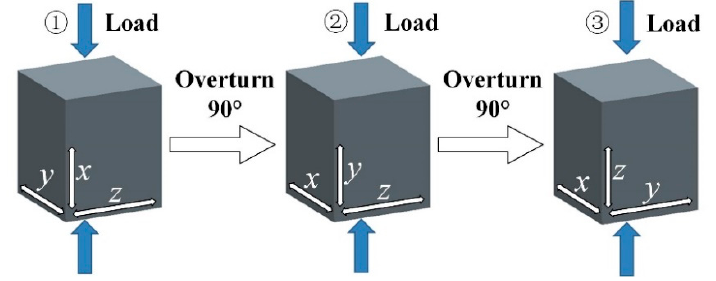
Figure 1. Schematic illustration of MDF.